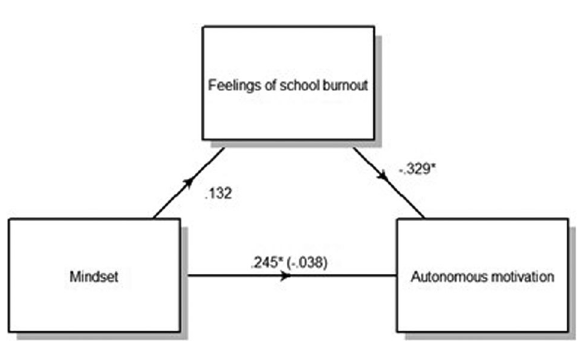
Fig. 1 Standardized regression coef fi cients for the association between mindset and autonomous motivation as mediated by feelings of school burnout, controlling for gender, age and pre- measurement of autonomous motivation. * p < 0.025 (Bonferroni correction).